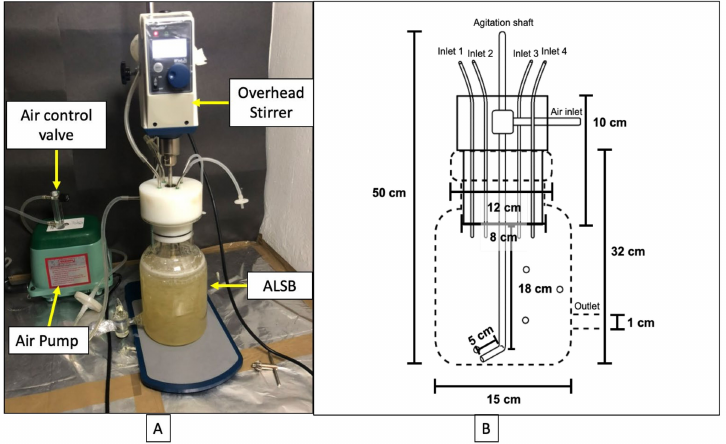
Figure 1. ( A ) Working setup of Air-L-Shaped Bioreactor (ALSB) with fungal culture and ( B ) schematic diagram of